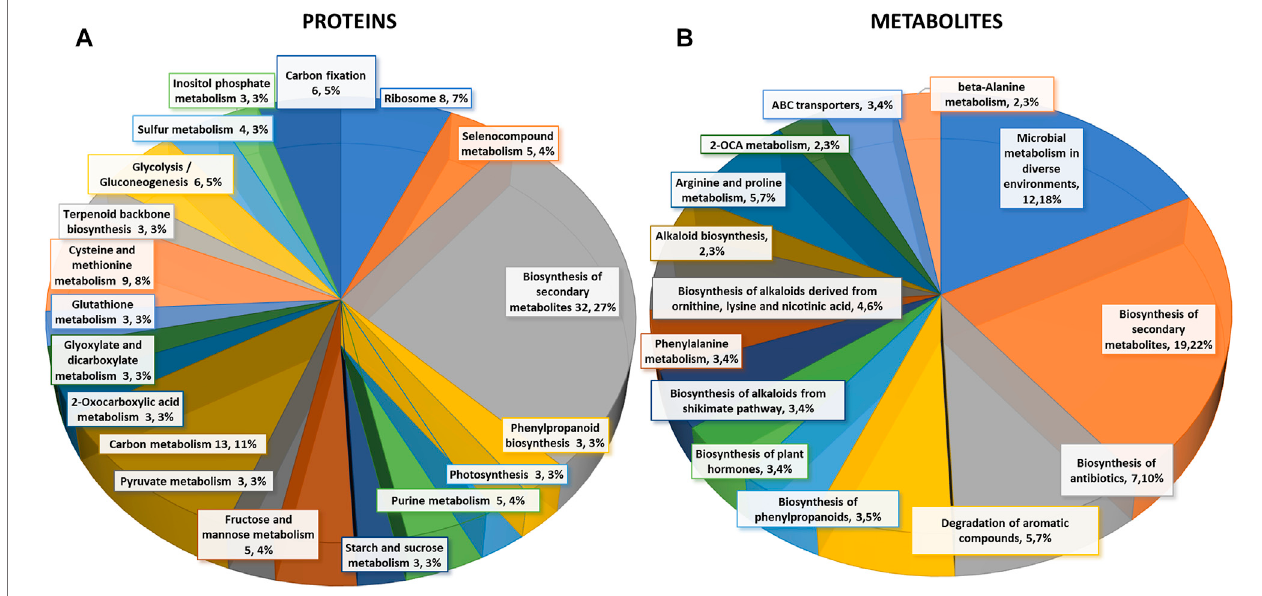
FIGURE 2 | Differential changes of proteins and metabolites in mock-primed and Pst -primed dir1-1 mutant and WT guard cells. (A) . Biological function proteins found in KEGG pathways that are differentially abundant in WT versus dir1-1 Pst -primed guard cells. (B) . Biological functions metabolites found in KEGG pathways that are differentially abundant in WT versus dir1-1 Pst -primed guard